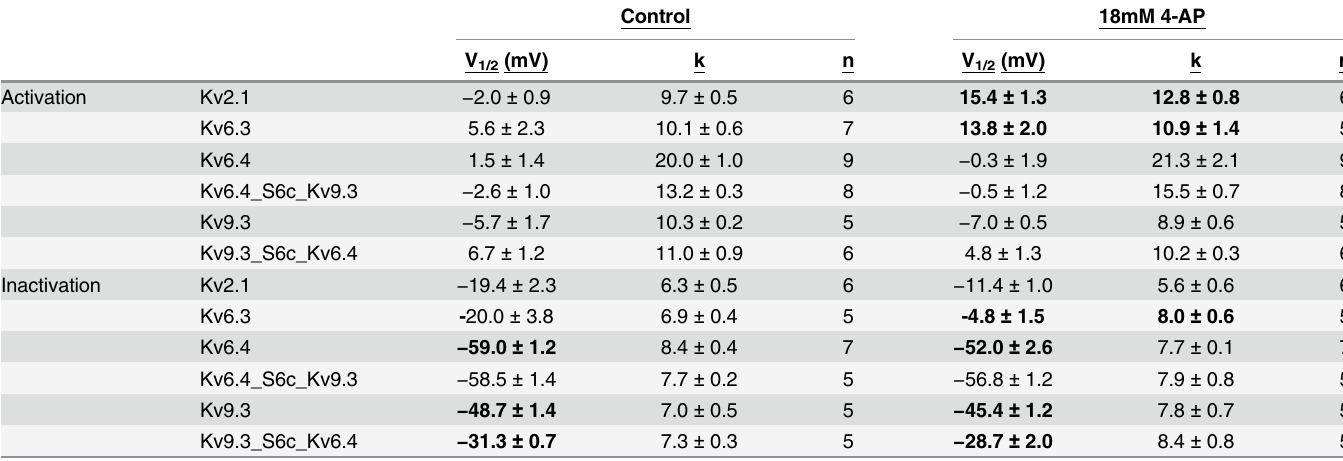
Table 1. Overview of the biophysical properties for Kv2.1, Kv2.1/Kv6.4, Kv2.1/Kv6.4_S6c_Kv9.3 and Kv2.1/Kv9.3_S6c_Kv6.4